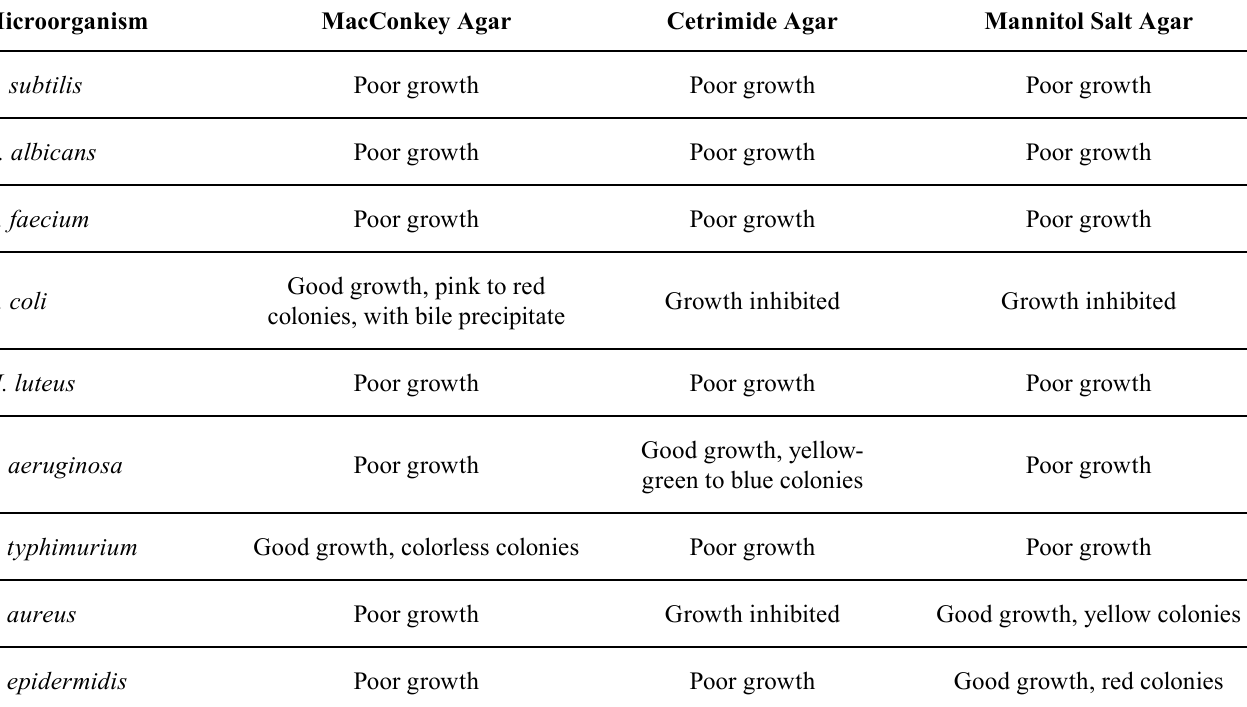
TABLE I – E xpected cultural responses of Bacillus subtilis (ATCC 6633), Candida albicans (ATCC 10231), Enterococcus faecium (ATCC 8459), Escherichia coli (ATCC 8739), Micrococcus luteus (ATCC 10240), Pseudomonas aeruginosa (ATCC 9027), Salmonella typhimurium (ATCC 14028), Staphylococcus aureus (ATCC 6538), and Staphylococcus epidermidis (ATCC 12228) microbial growth in MacConkey Agar, Cetrimide Agar, and Mannitol Salt